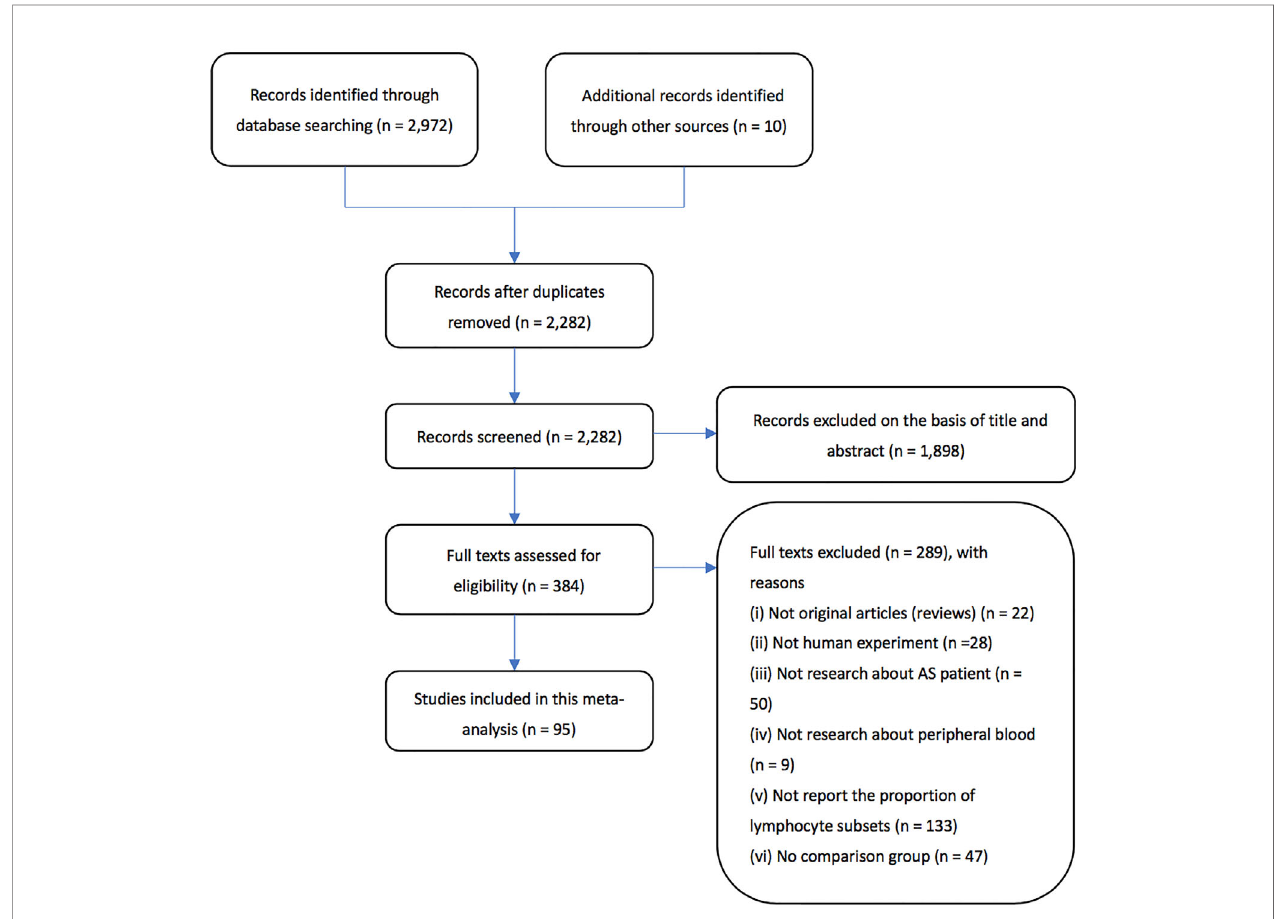
FIGURE 1 | Flow chart of the literature search and study selection